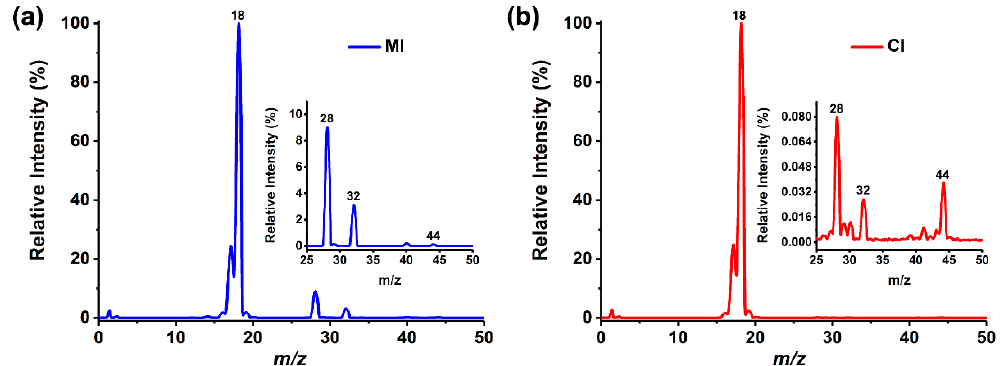
Figure 2. Typical mass spectra of ultrapure water detected by: ( a ) MIMS and ( b ) CIMS. The illustrations are partial enlargements of the mass spectra.